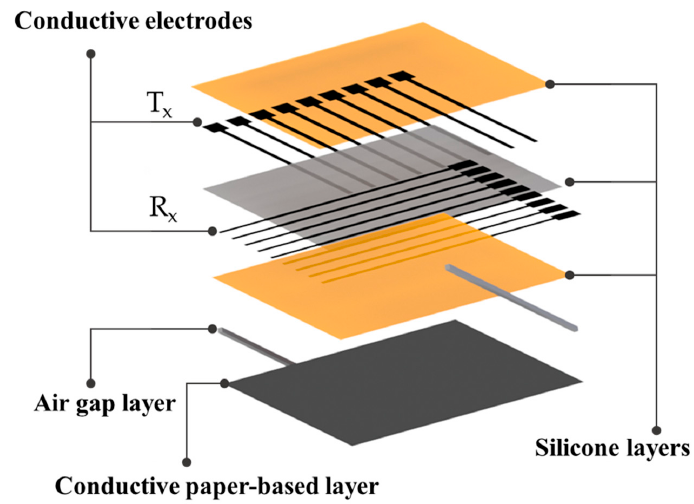
Figure 3. Schematic illustration of the proposed sensor’s internal